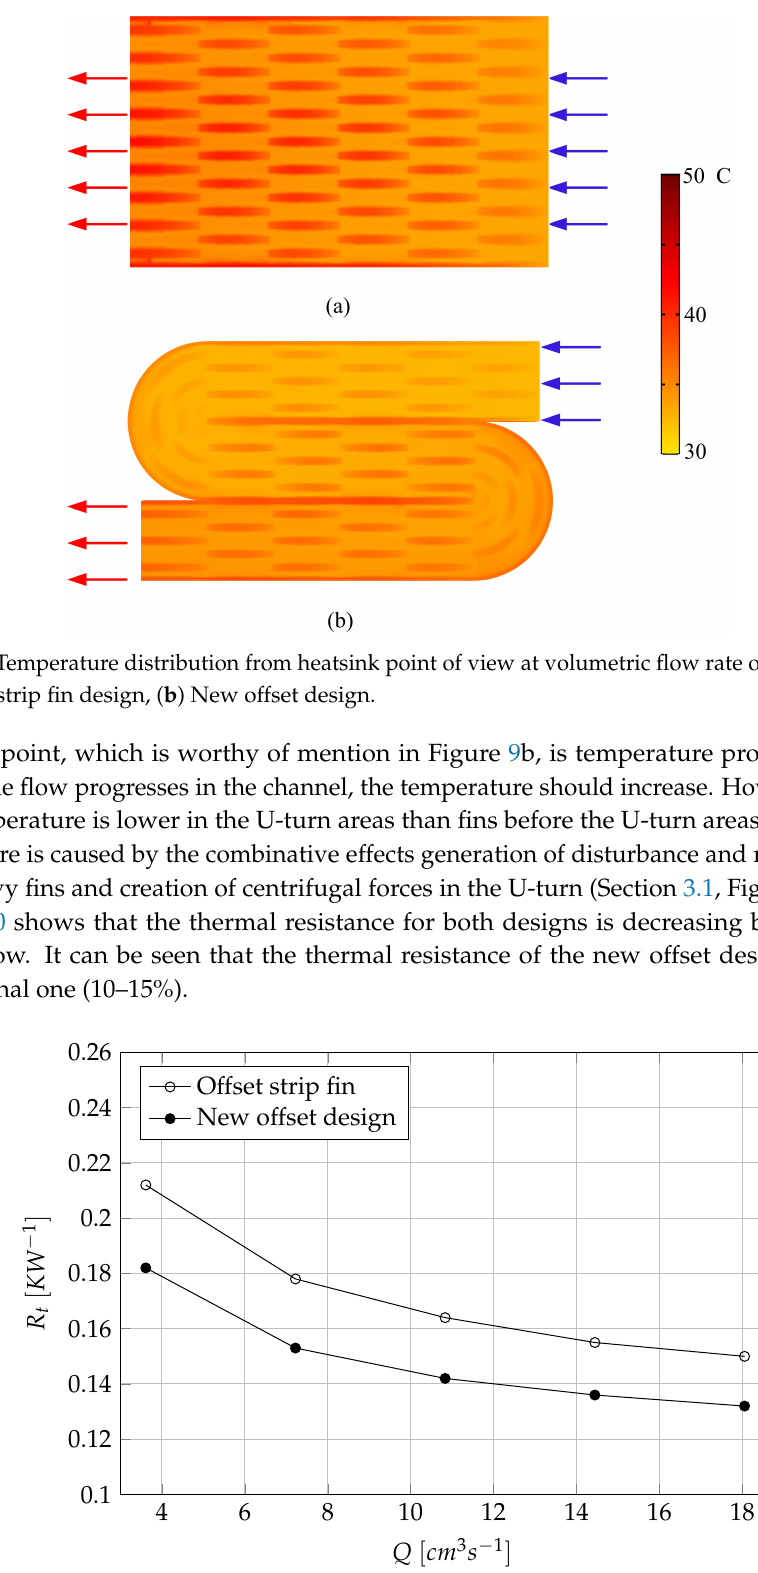
Figure 10. Thermal resistance ( R t ) in different volumetric flow rates (Q) for conventional offset strip fin design and new offset